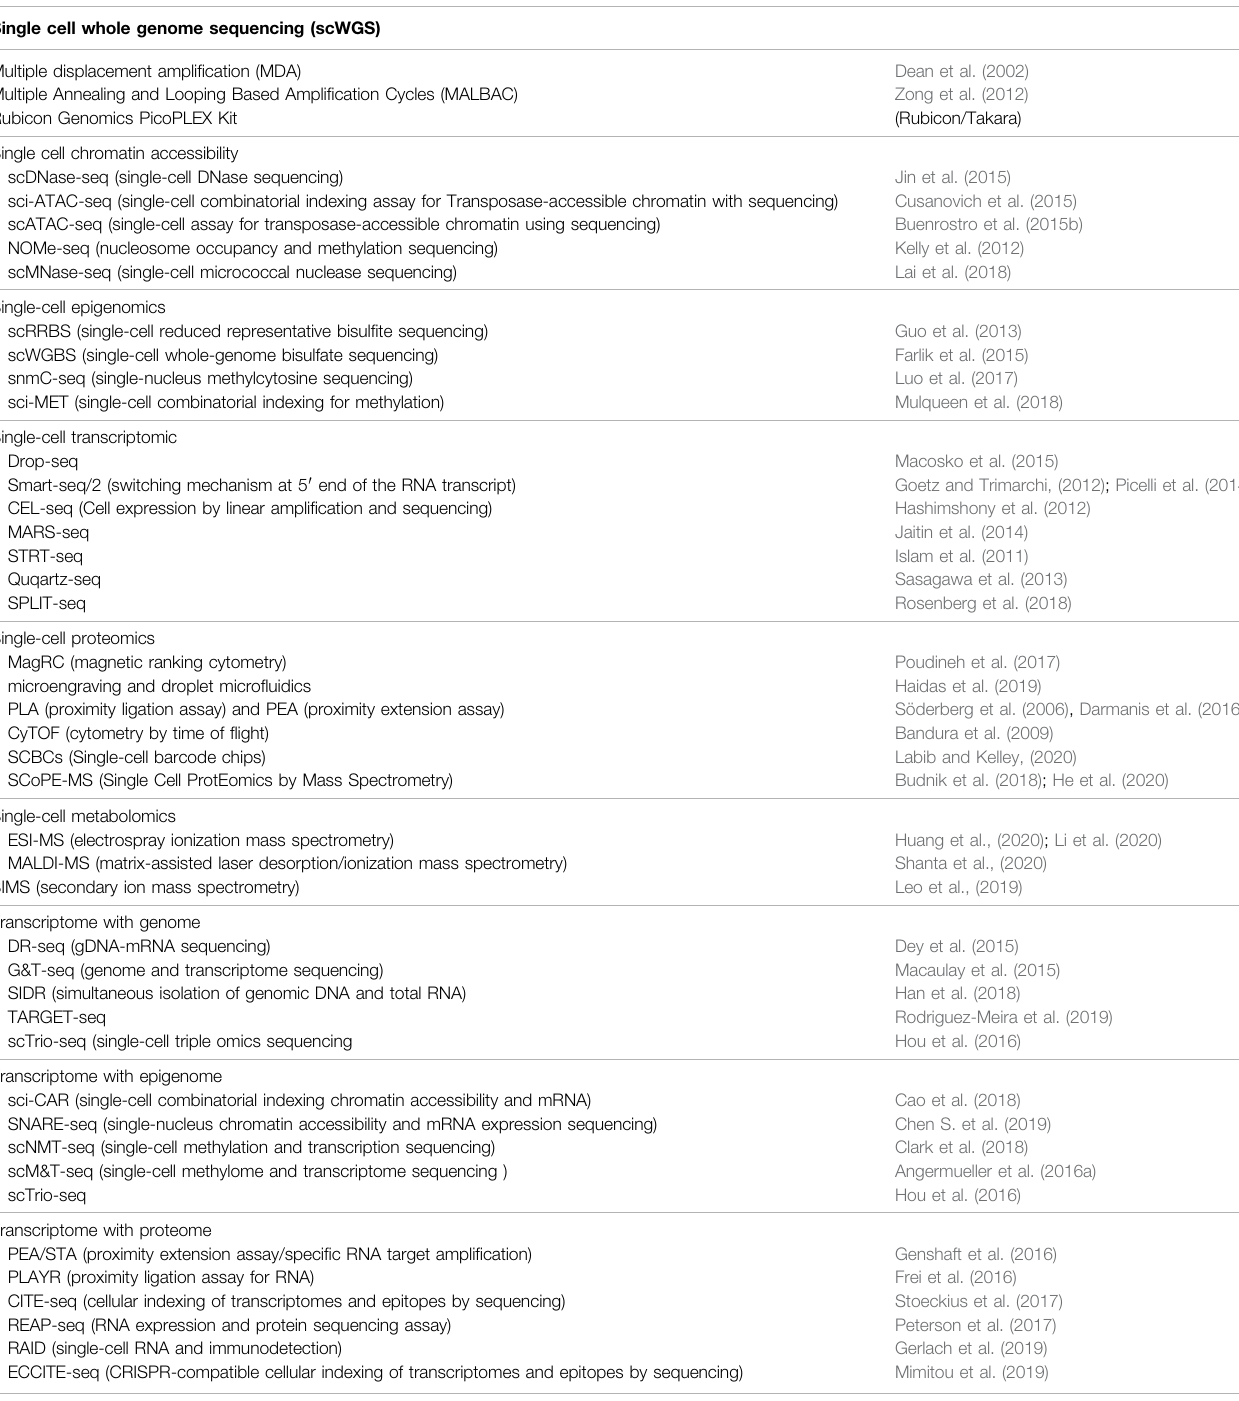
TABLE 1 | Single cell multi-omics